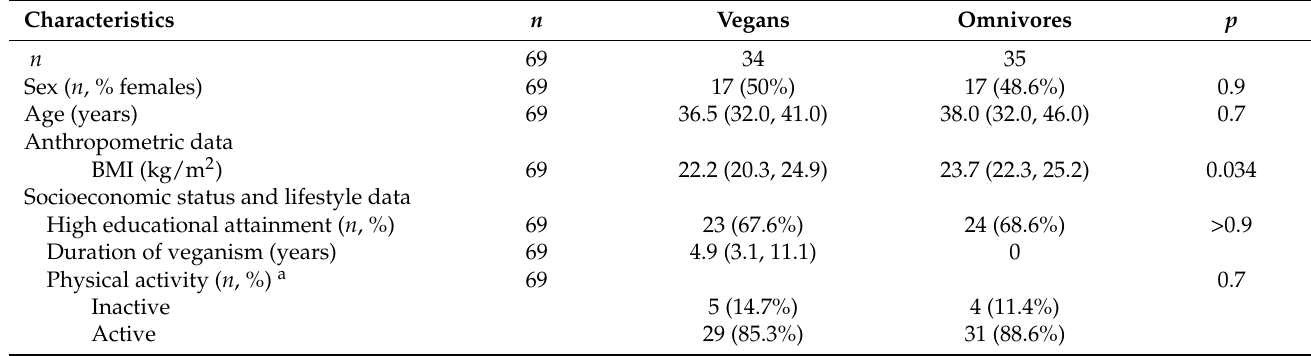
Table 1. Characteristics of vegans and omnivores ( n =